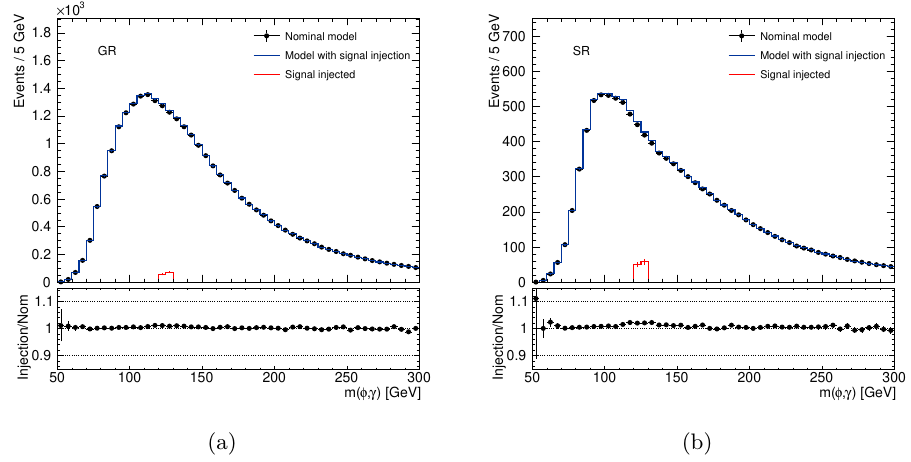
Figure 5 . Comparison of the m ( φ, γ ) distributions predicted by the model for (a) the GR and (b) the SR, derived with and without an injection of approximately 130 H → φ γ signal events in the GR